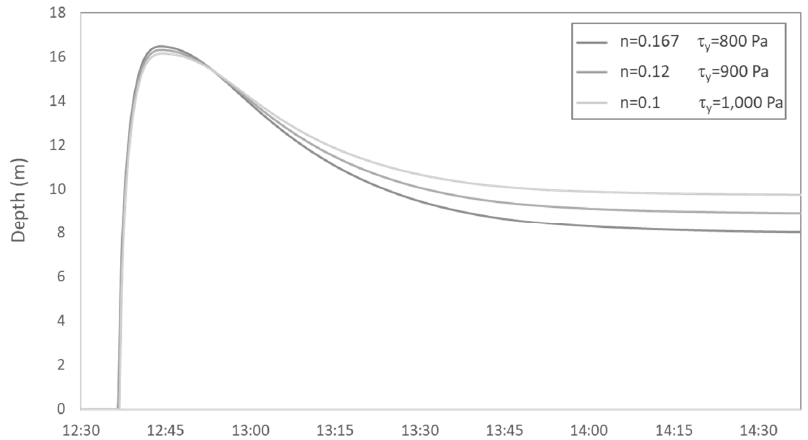
Figure 12. The railway bridge depth time series from Figure 3, simulated with the original parameters and two simulations with lower n ‐ values and higher yield strengths that generated similar arrival times. arrival times.